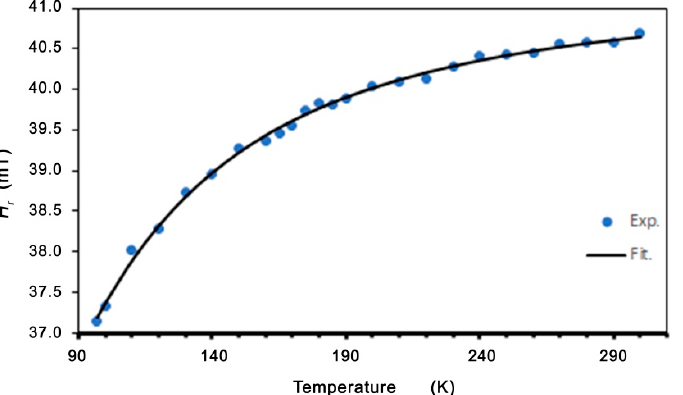
Figure 8. Temperature dependence of the resonance field for Zn 0.8 Co 0.2 O/Ag. Theoretical line fitted based on Equation (3).